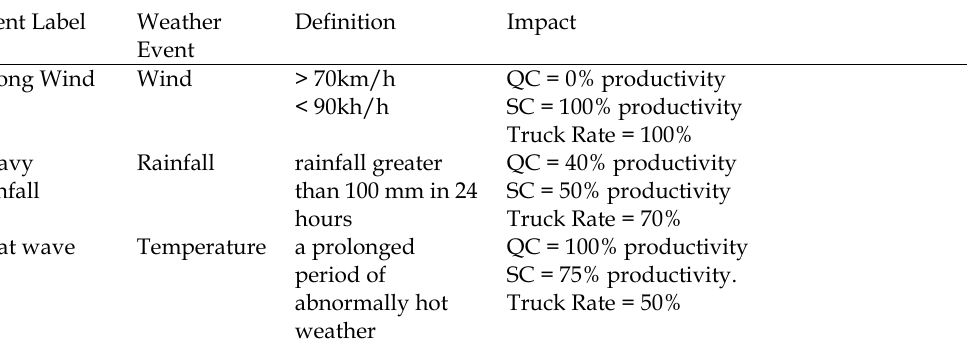
Table 4. Examples of user defined events including the impact on productivity of assets